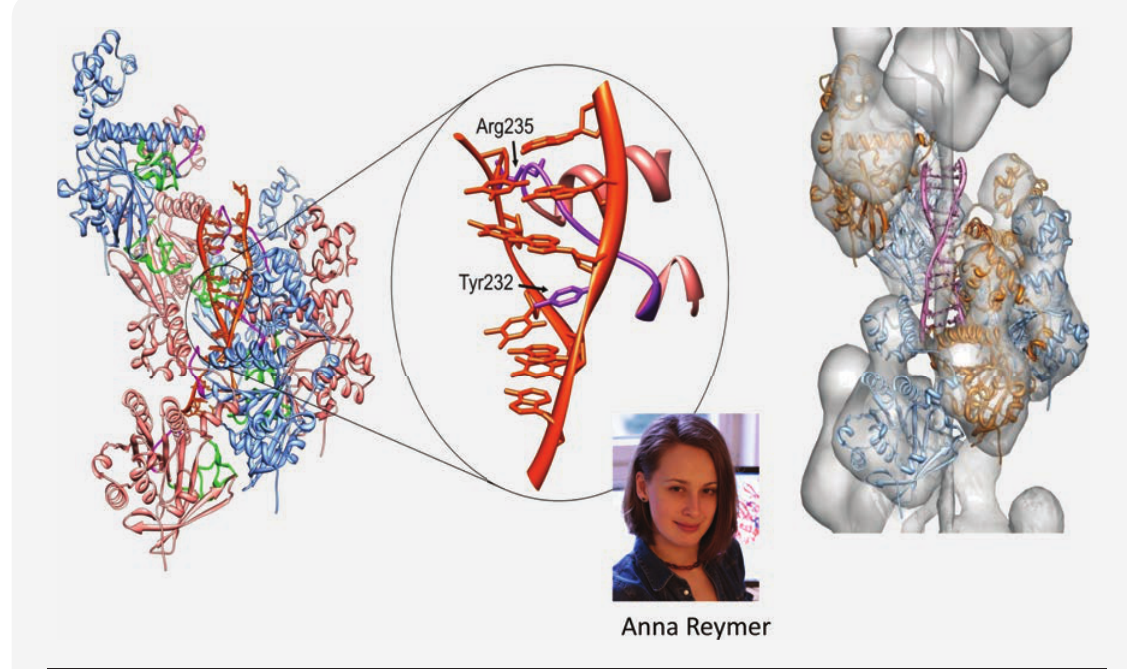
Figure 8. Structure of human Rad51-DNA complex determined from Site Specifi c Linear Dichroism by Molecular Replacement (SSLD-MR) spec- troscopy and molecular modeling 31 . To the right an electron density map from electron microscopy showing agreement of contours with model. Figure adapted from results kindly provided by Dr Anna